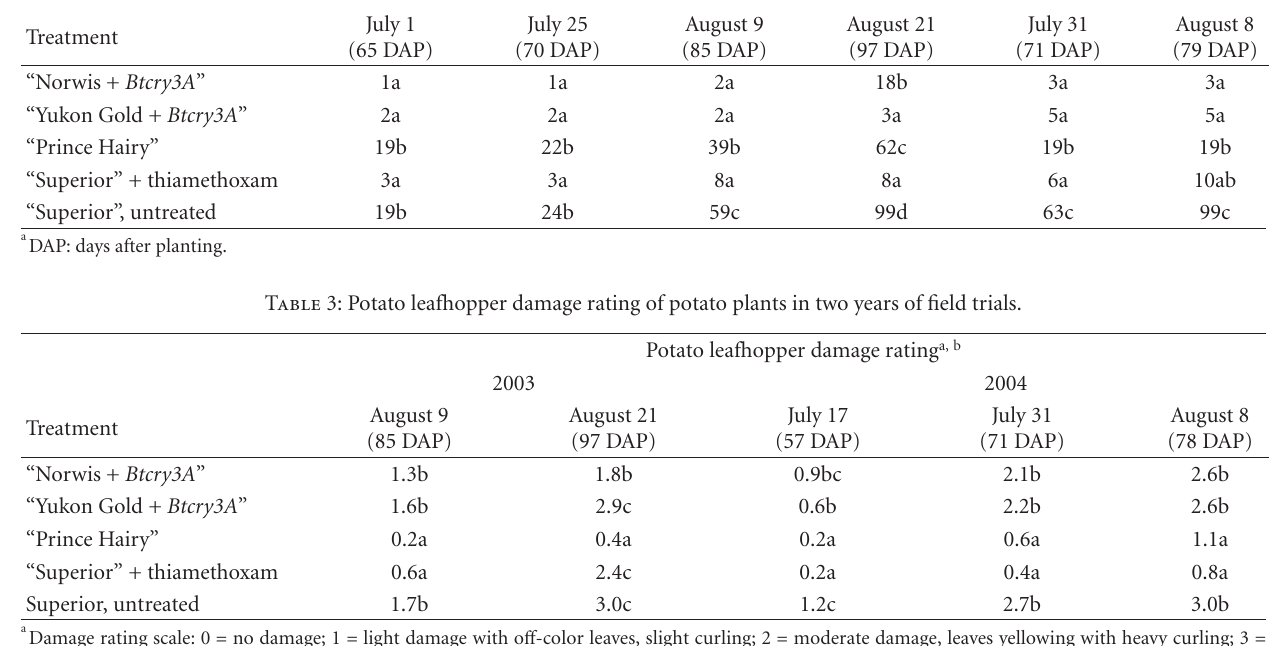
Table 2: Percent defoliation of potato plants caused by Colorado potato beetle in two years (2003 and 2004) of field trials in Bridgeton, NJ.